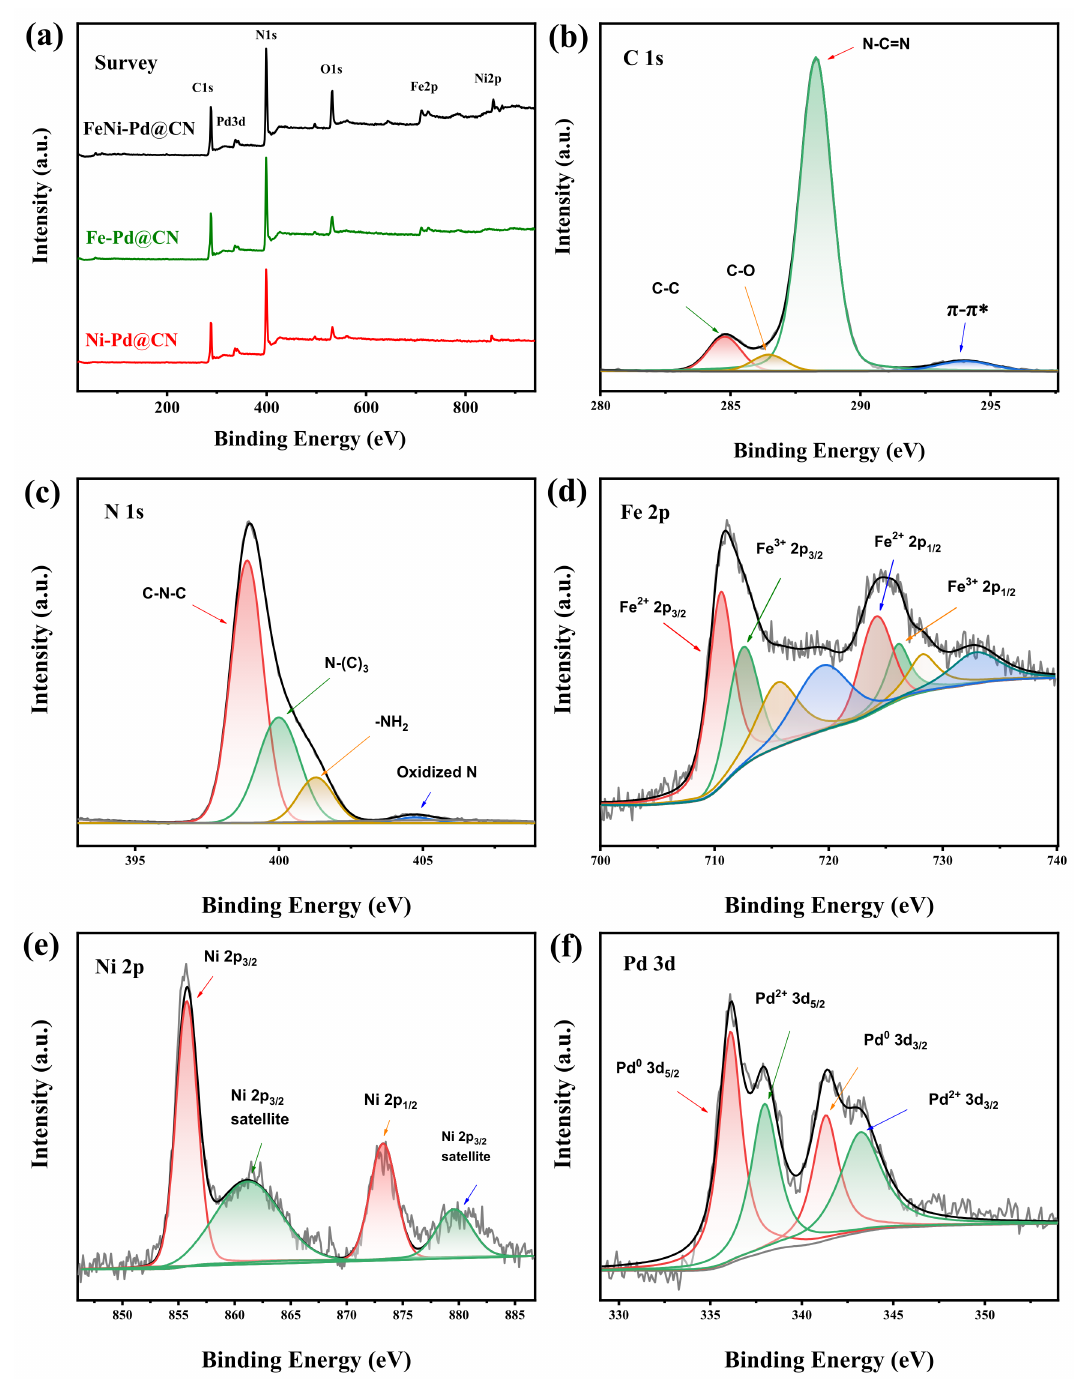
Figure 3. ( a ) XPS survey of samples. ( b ) C1s spectra; ( c ) N 1s spectra; ( d ) Fe 2p spectra; ( e ) Ni 2p spectra; and ( f ) Pd 3d spectra of